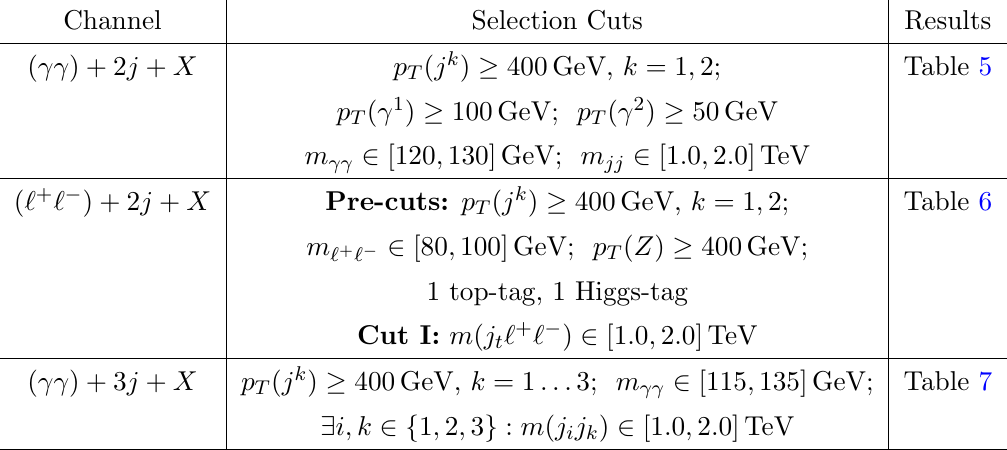
Table 4 . Summary of selection cuts used for each of the three channels analyzed in this section. See text for more details.